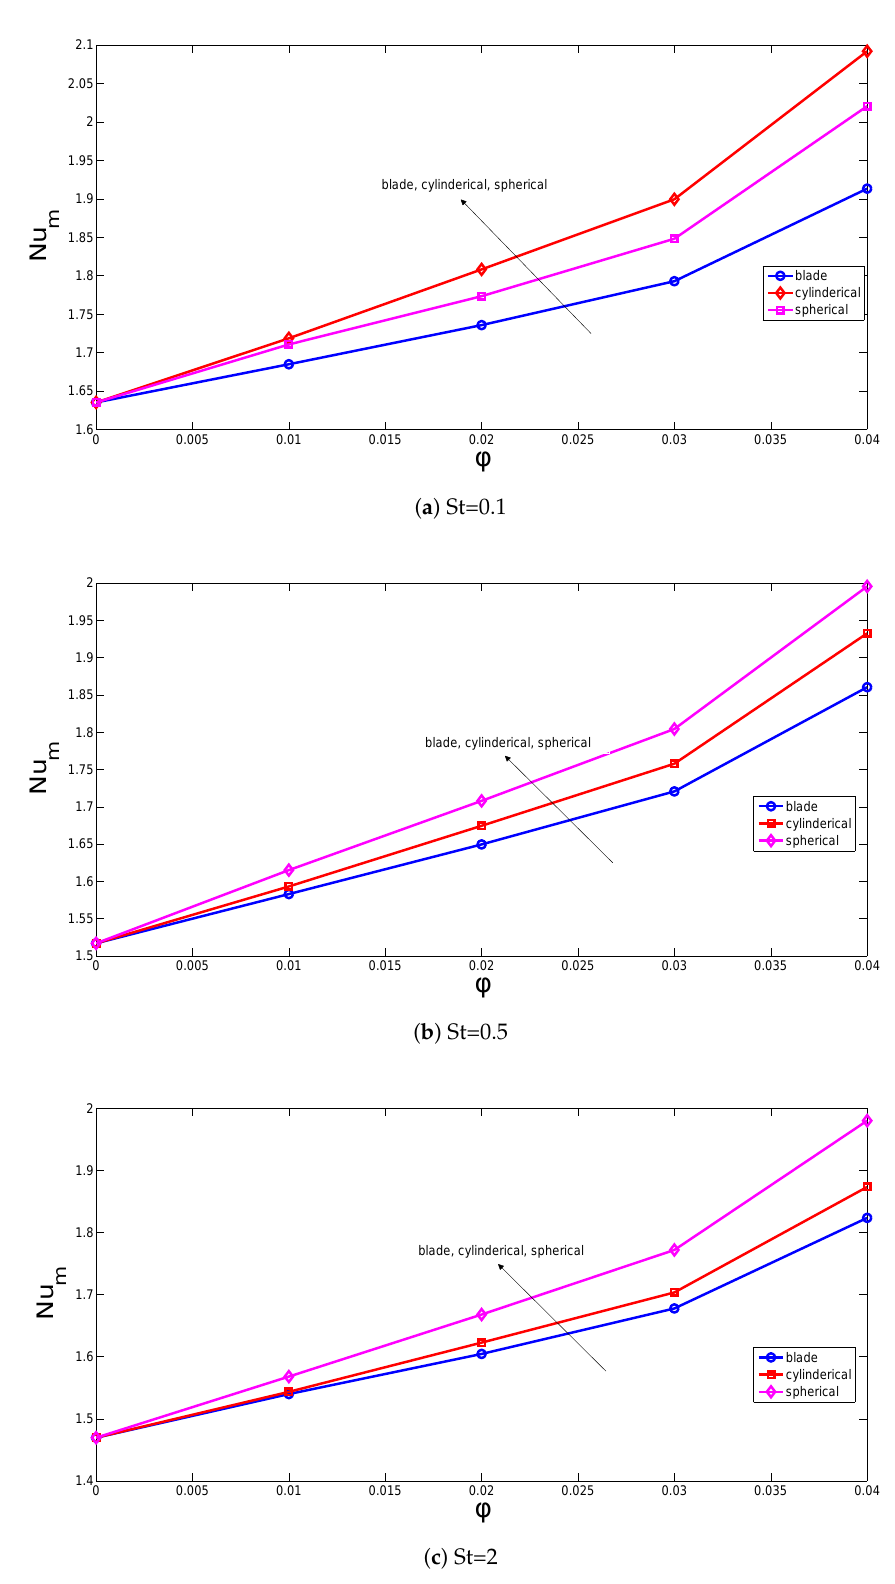
Figure 9. Average Nusselt numbers versus solid particle volume fractions for various pulsating frequencies and nanoparticle